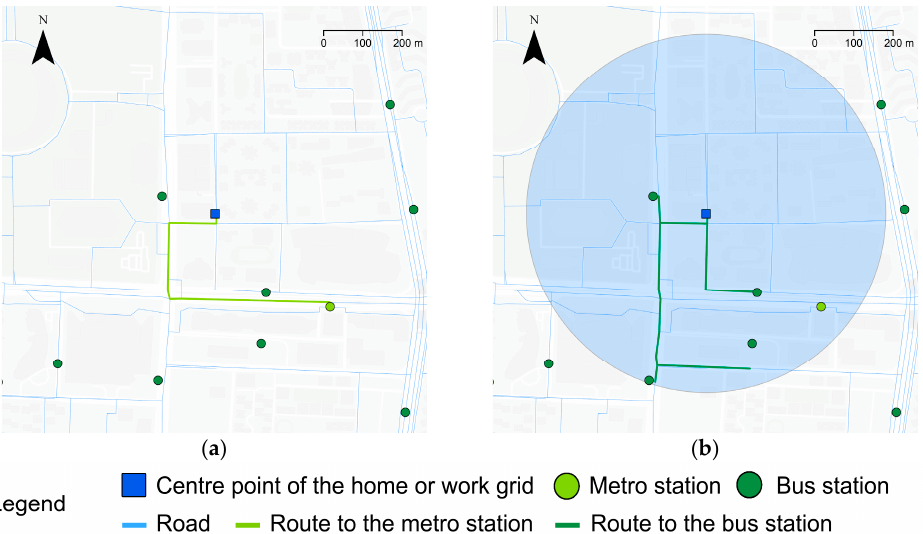
Figure 6. Simulation of commuter paths: ( a ) metro station; ( b ) bus station. Map data sources: Esri, HERE, Garmin, FAO, NOAA, USGS, (c) OpenStreetMap contributors.